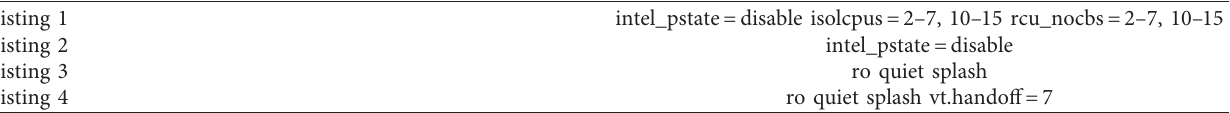
Table 2: Kernel configurations for systems 1 and